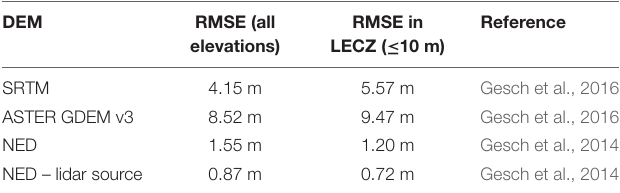
TABLE 1 | Accuracy assessment results for DEMs over CONUS. DEM RMSE (all RMSE in elevations) LECZ ( ≤ 10